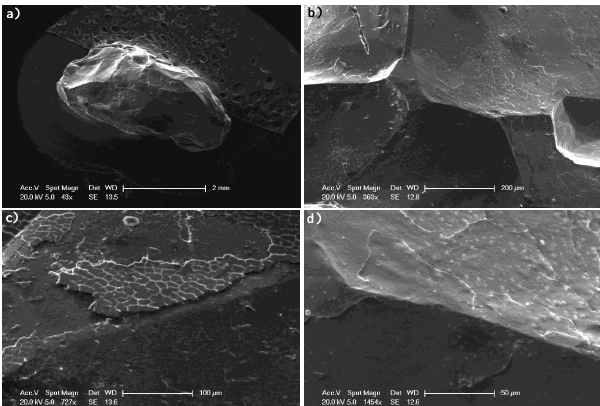
Figure 6. SEM imagery for an olivine grain from mantle-derived peridotite. (a) Olivine grain bounded by mounting tape (top) show- ing overall shape of grain. (b) Detailed image of primary surface (unfractured) of olivine typical of grains forming an interlocking Fig. 6 [Jones et al., Solid Earth, 2014] mosaic within mantle peridotite. (c) Polygonal textured surface flaking. (d) Common small-scale surface flakes on the mantle olivine surface. Higher relief is observed at the edge of the flake, creating a stepped topography.